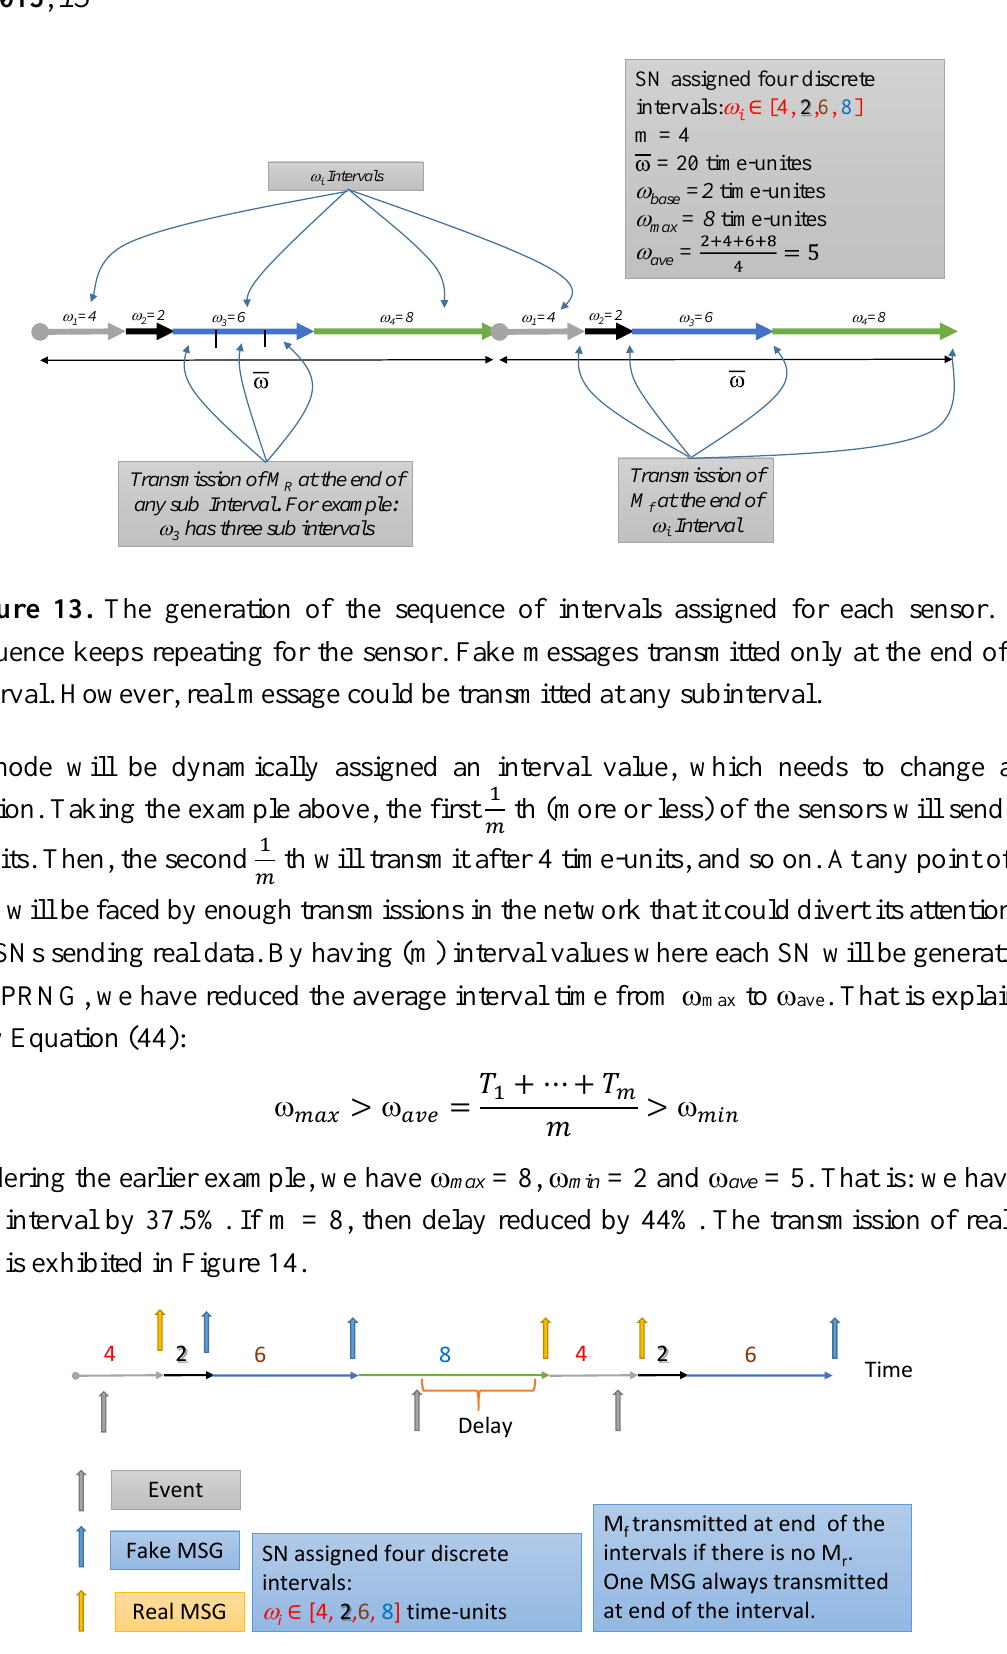
Figure 14. SN is assigned a sequence of intervals, which repeat until sensor lifetime ends. At the end of each interval, the sensor sends a fake message if it does not have an event to report. This should cause different delay times depending on the event relative arrival time and the length of the